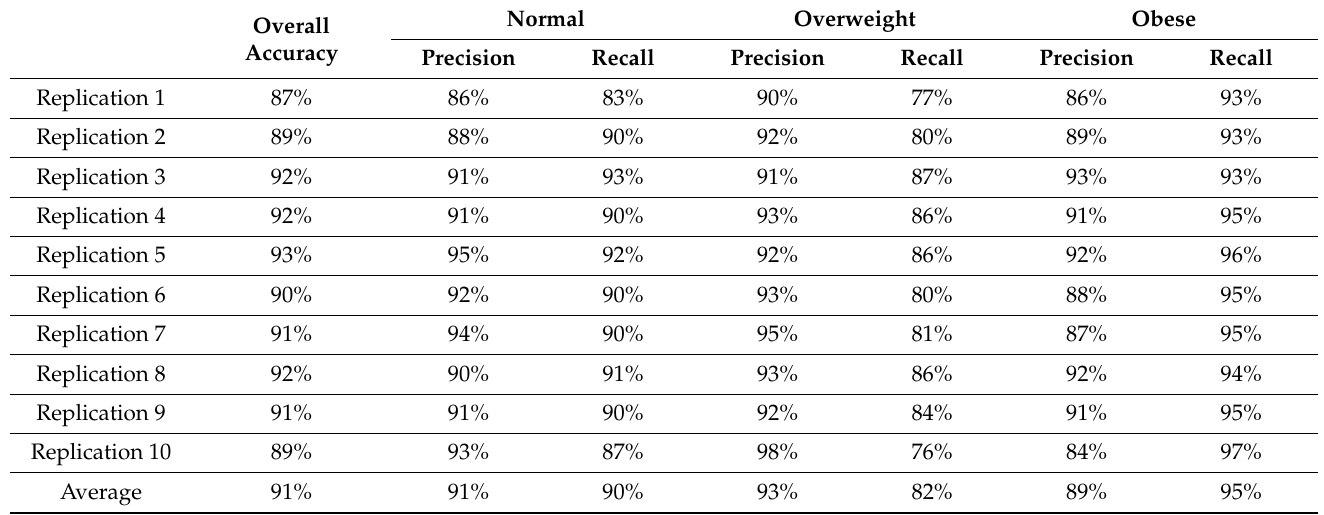
Table 5. Results to show the consistency of random forest’s